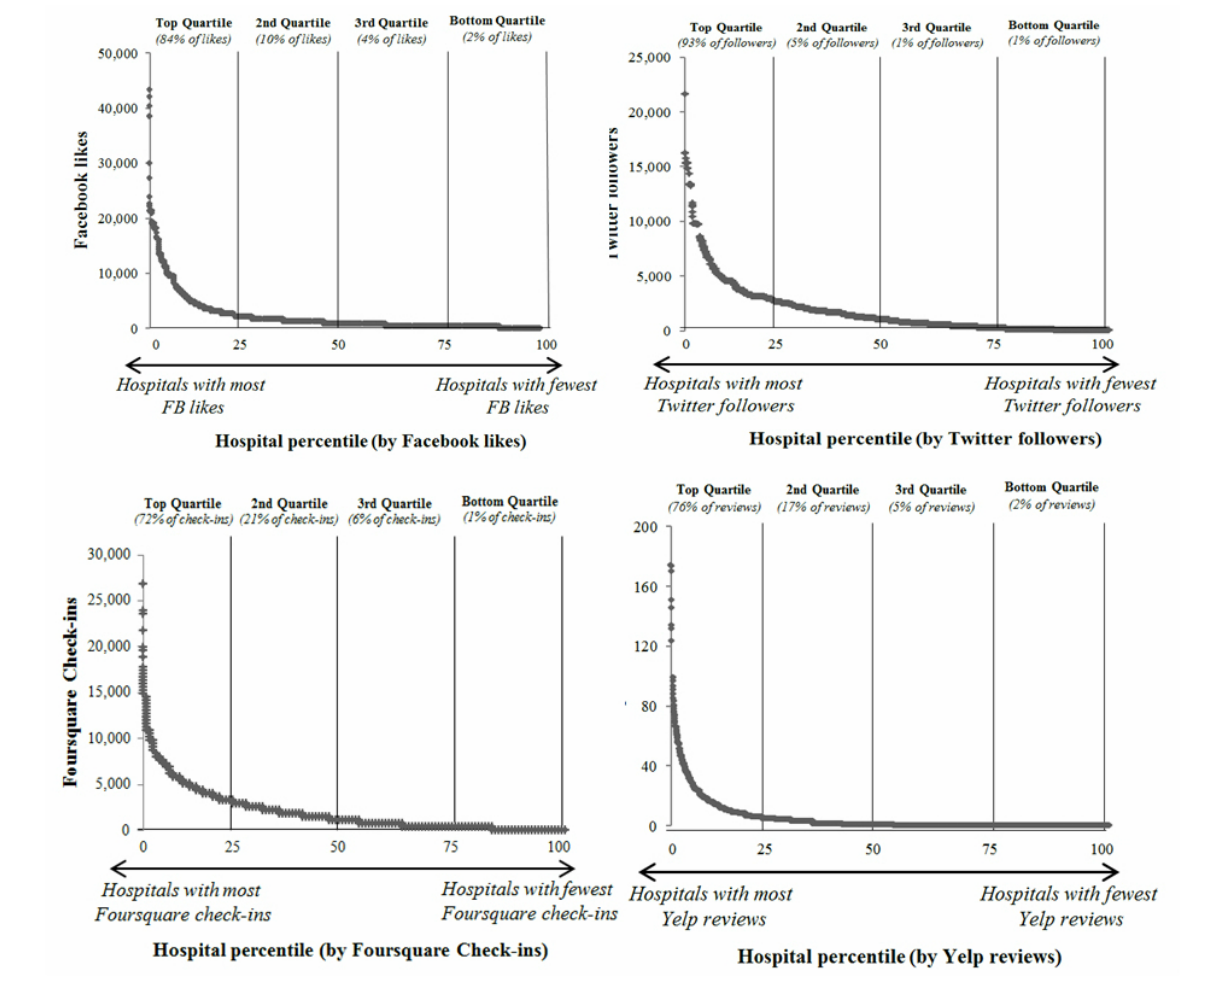
Figure 1. Distribution of utilization of social media across US hospitals.